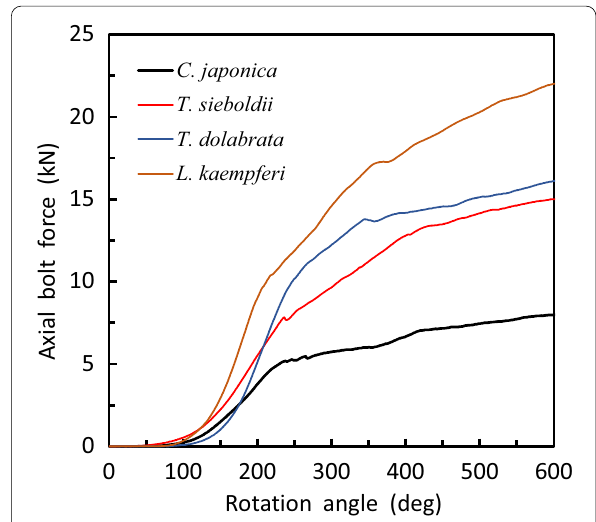
Fig. 4 Relationship between axial bolt force and rotation angle